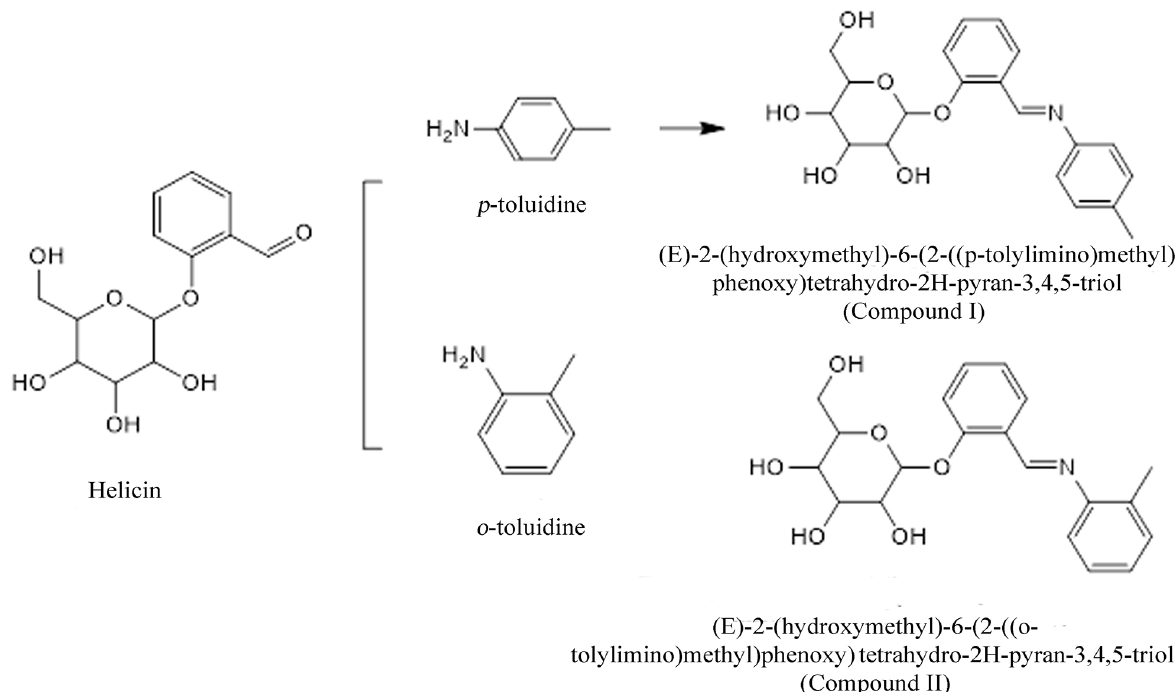
Figure 1. Structures and abbreviations of synthesized Schiff